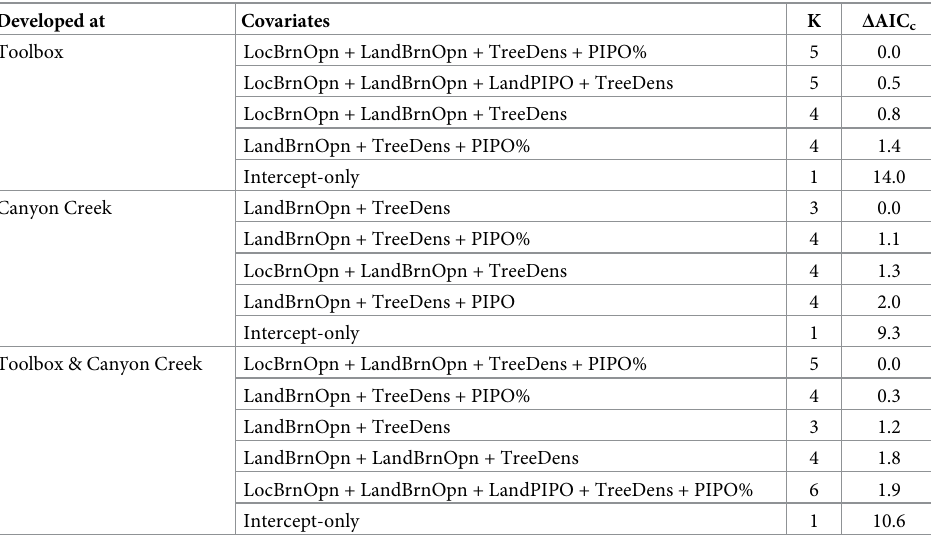
Table 5. Model selection results for weighted logistic regression models describing nest site selection by white- headed woodpeckers in burned forest. Models within 2 AIC c units from the top-ranked (lowest AIC c ) model and the intercept-only model are presented. The total number of candidate models considered were 386, 638, and 64 for Tool- box, Canyon Creek, and pooled datasets, respectively. Complete lists of candidate models for each dataset are included in S1 Data. Complete covariate names and descriptions are in Table